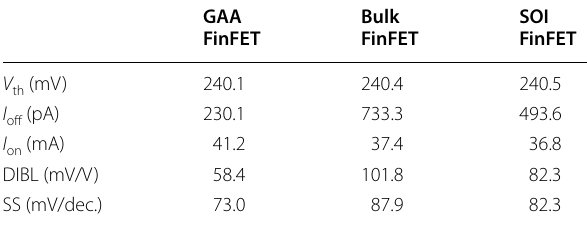
Table 1 Summary of electrical characteristics for GAA, bulk and SOI FinFETs, where they have the similar fin height of 20 nm, fin width of 17 nm, gate length of 22 nm, and EOT of 0.9 nm